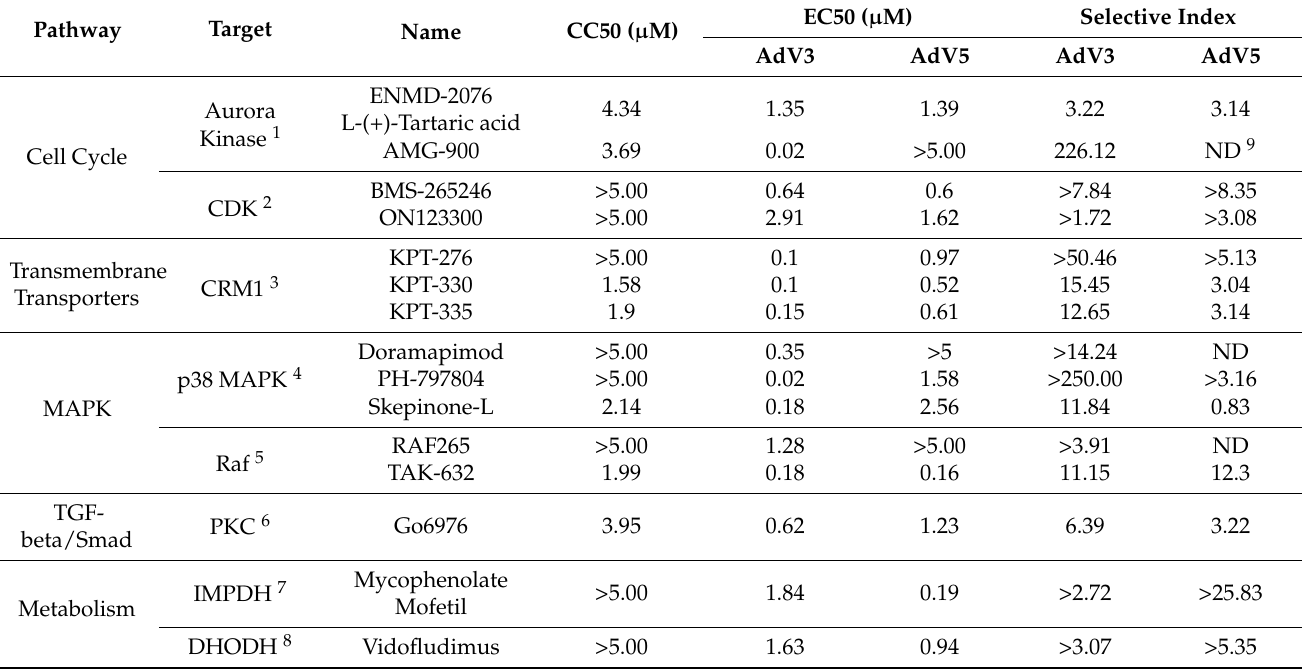
Table 4. Anti-ADV activities of hit compounds targeting other host